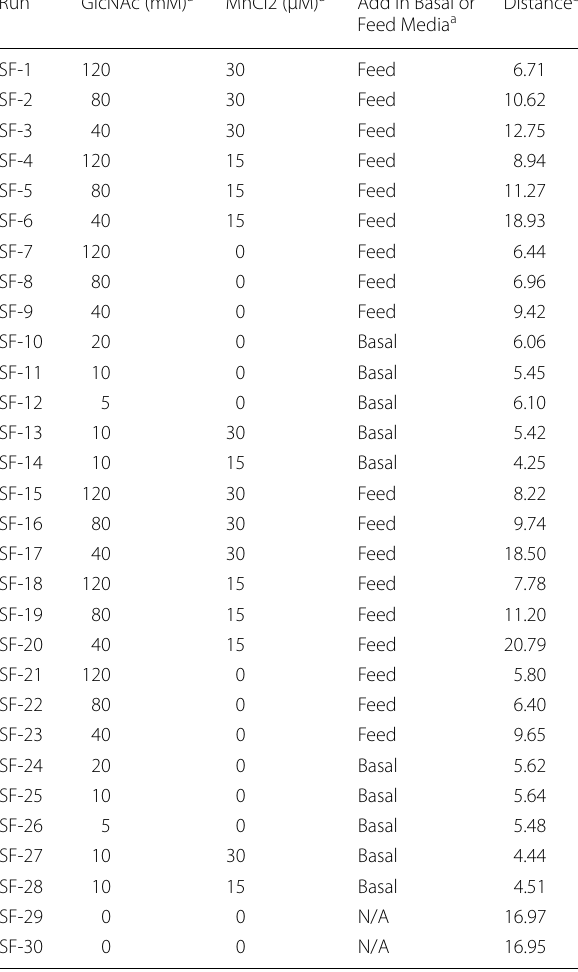
Table 1 Design of the experiment for investigating the glycan profile adjustment in response to supplement